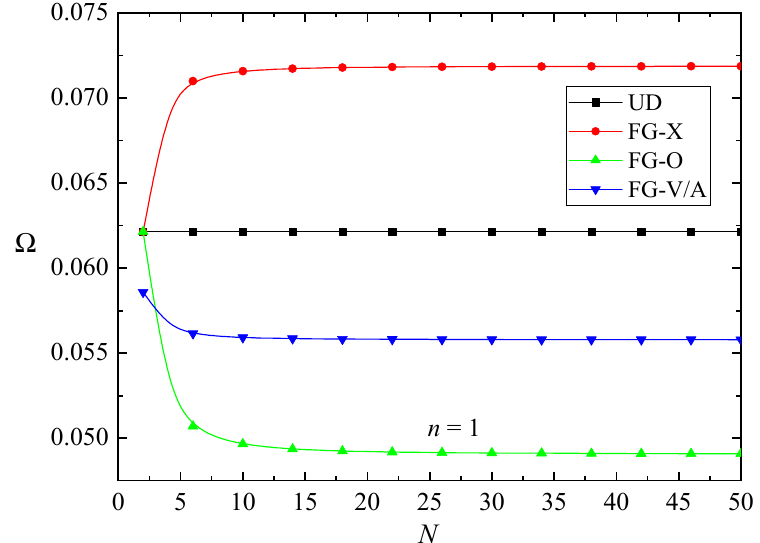
Figure 3. The e ff ects of the total layer number N on the fundamental frequency Ω of the FG-GPLRC Figure 3. The effects of the total layer number N on the fundamental frequency Ω of the FG-GPLRC beams’ absence of magnetic fields and elastic beams’ absence of magnetic fields and elastic foundation.